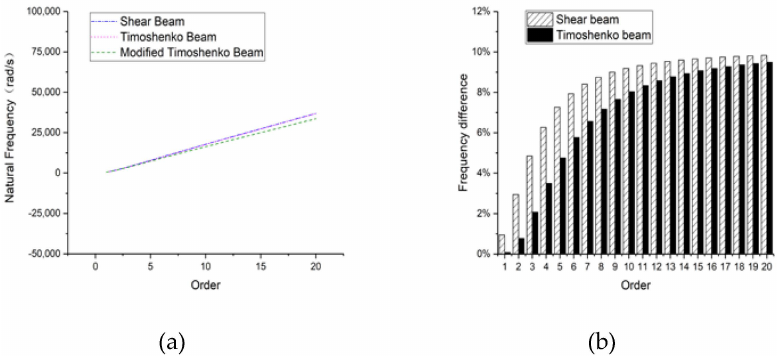
Figure 14. Natural frequencies of the 4-m-long beam: ( a ) overall frequency curve and ( b ) frequency di ff erence compared with a modified Timoshenko beam.